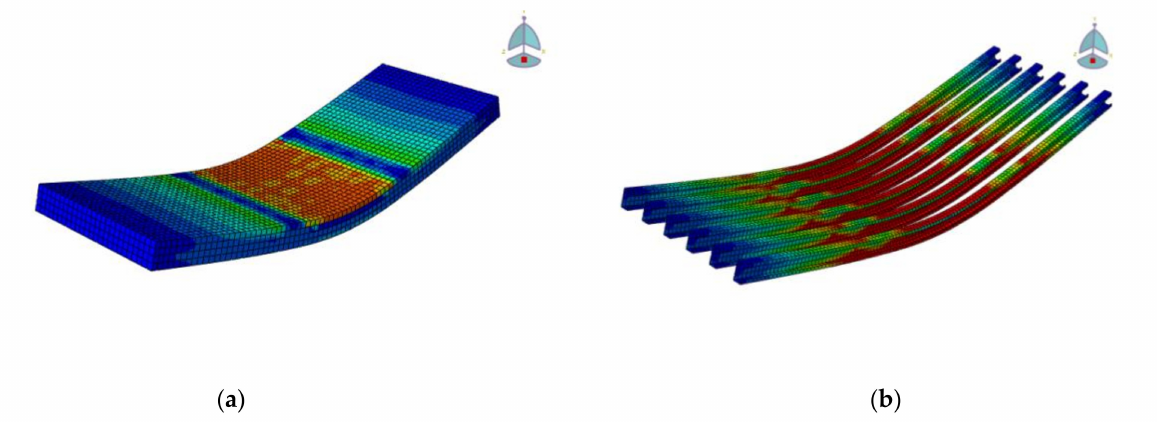
Figure 12. Stress contour of composite slab under ultimate load. ( a ) Foam concrete slab; ( b ) Cold-formed thin-walled C steel channels.